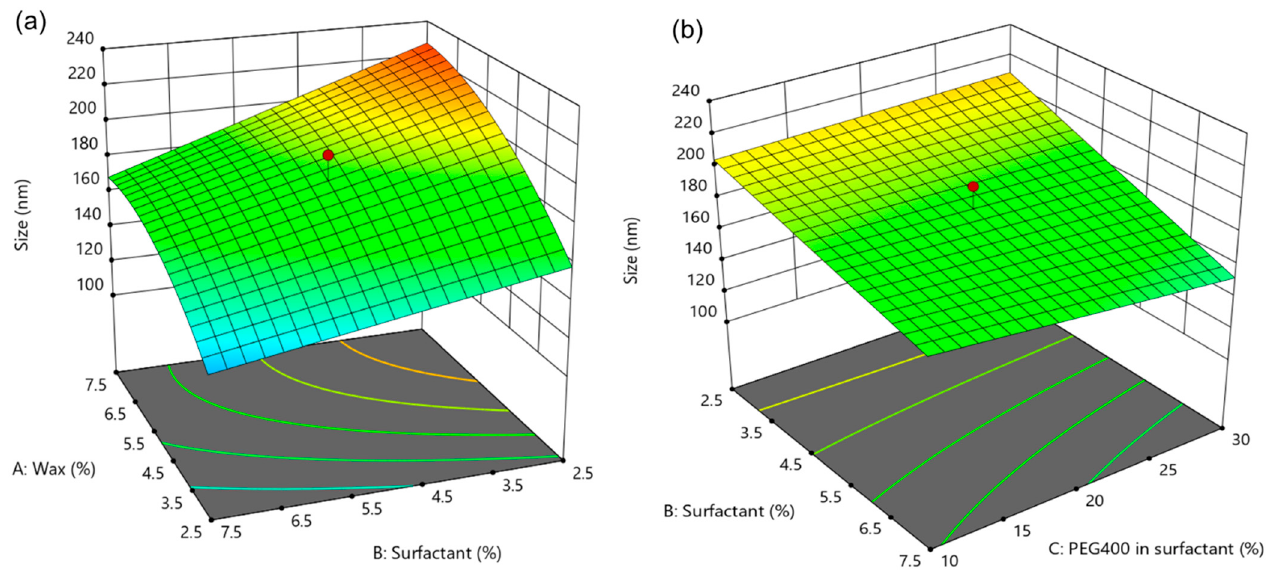
Figure 1. The response surface plot presents the effects of wax, surfactant, and percentage of